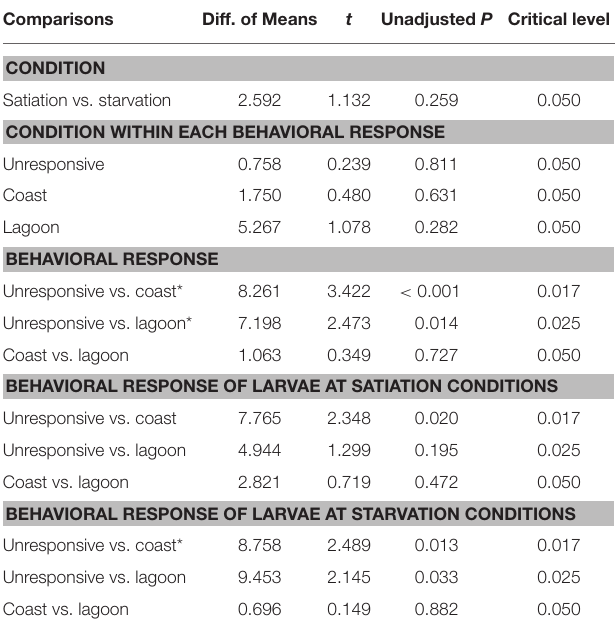
TABLE 6 | Multiple comparisons’ statistical output for the Maximum Consecutive Time (MaxCT) index calculated for all larvae exhibiting an unresponsive behavior. Comparisons Diff. of Means t Unadjusted P Critical level